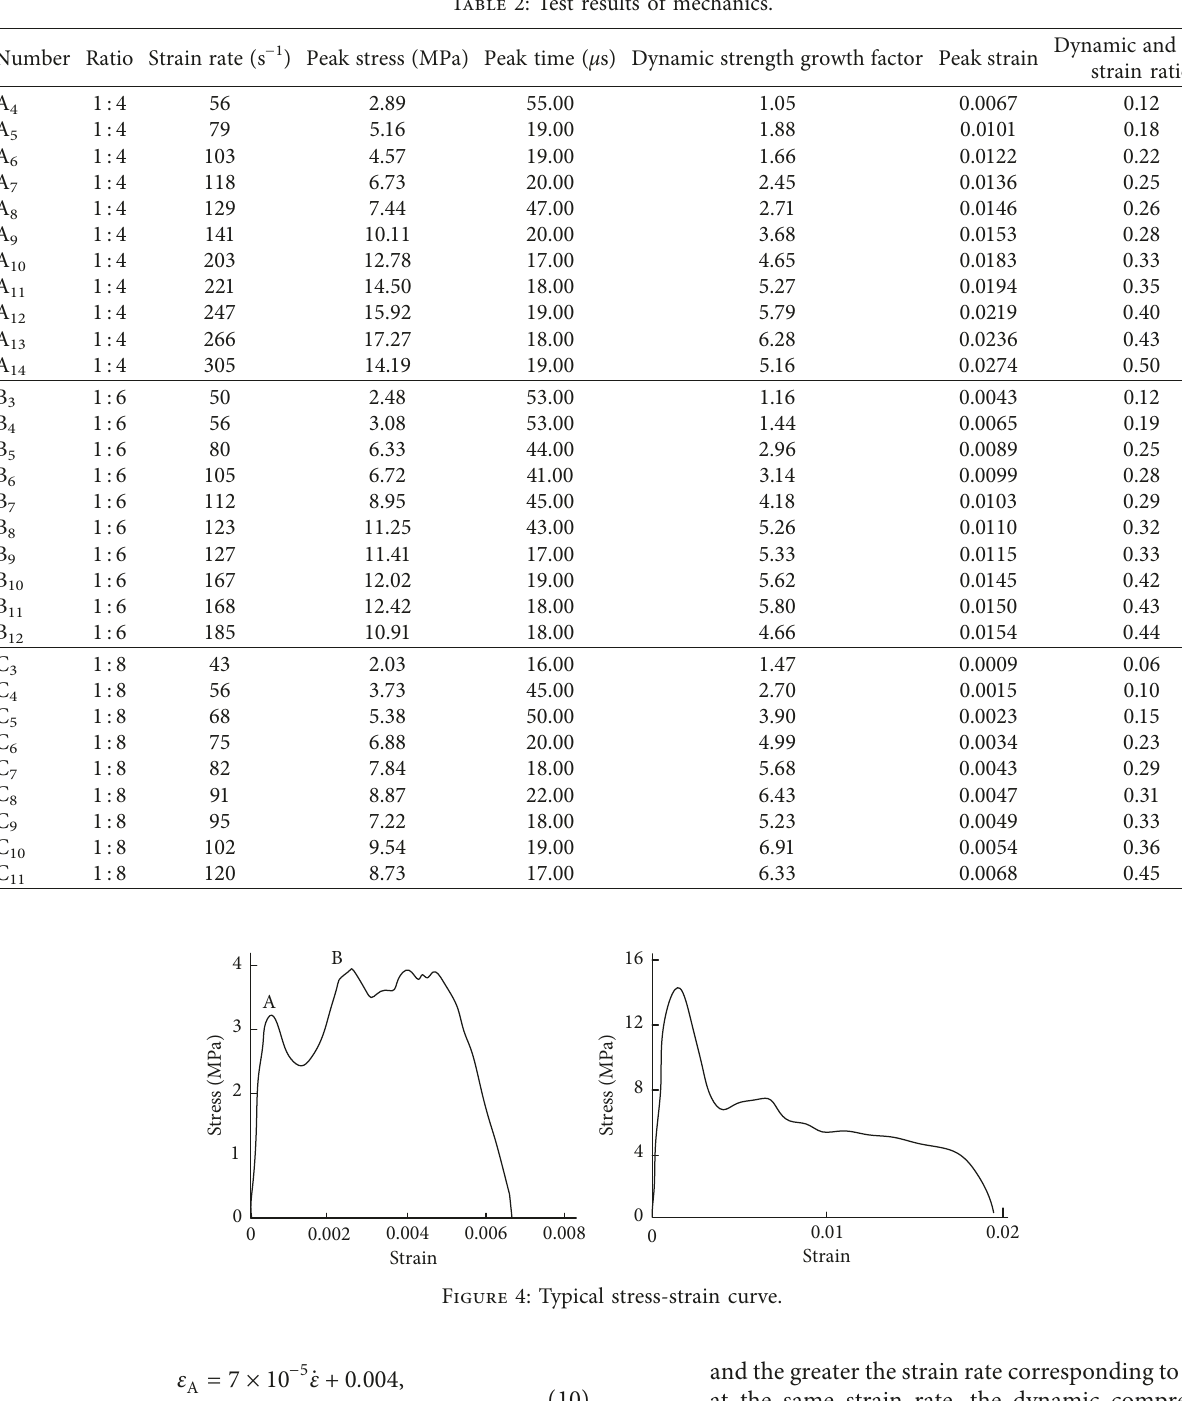
Table 2: Test results of